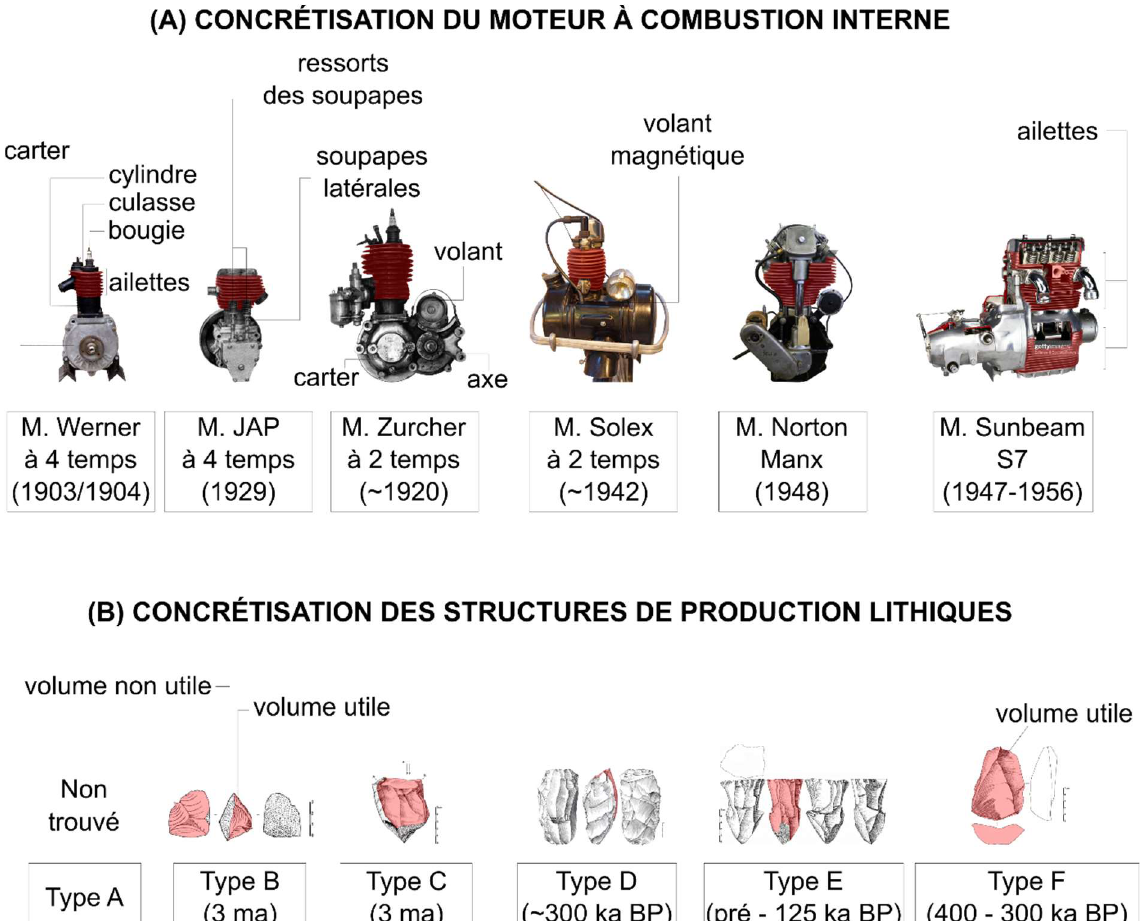
Figure 7. Exemple de concretisation des objets techniques. (A) Concrétisation du moteur à combustion interne (elaboré à partir de Simondon 2012: 20-26). La zone colorée en rouge dans chaque moteur correspond aux ailettes qui, au fil du temps, commencent à gagner plus de place dans la structure du moteur. Autrement dit, les ailettes commencent à s'intégrer plus efficacement avec les autres éléments. (B) Concrétisation des structures de production lithiques (elaboré à partir de Boëda 2013: 60-72), en utilisant des nucléus archéologiques provenants de différents sites archéologiques. La zone colorée en rouge dans chaque nucléus correspond aux volumes utiles ( sensu Boëda 2013: 89) qui, au fil du temps, commencent aussi à gagner plus de place dans la structure du